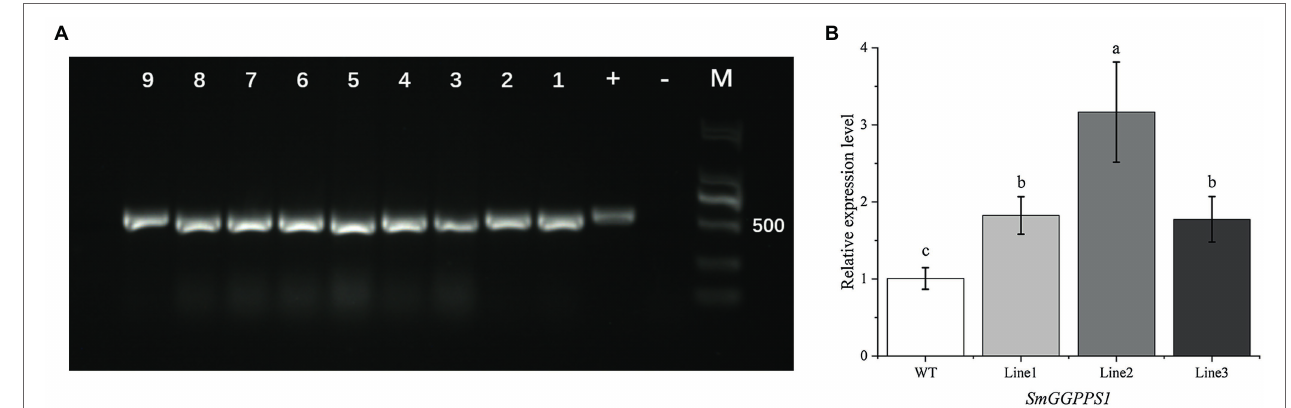
FIGURE 4 | (A) PCR detection of hpt II gene in transgenic plants, with pCAMBIA1302 vector as a positive control (+) and wild-type plants as a negative control ( − ), transgenic hairy root lines (1–4), transgenic regenerated plant leaves (5–9). (B) Relative expression level of SmGGPPS1 in overexpression transgenic regenerated plants by qRT-PCR analysis. Actin gene in S. miltiorrhiza was used as a reference for normalization. WT, wild-type plants; Line 1, 2, 3: roots of transgenic regenerated plants. Error bars represent means ± SD ( n = 3). Different letters indicate significant differences ( p < 0.05). The multiple comparison method used for the average level in this study was